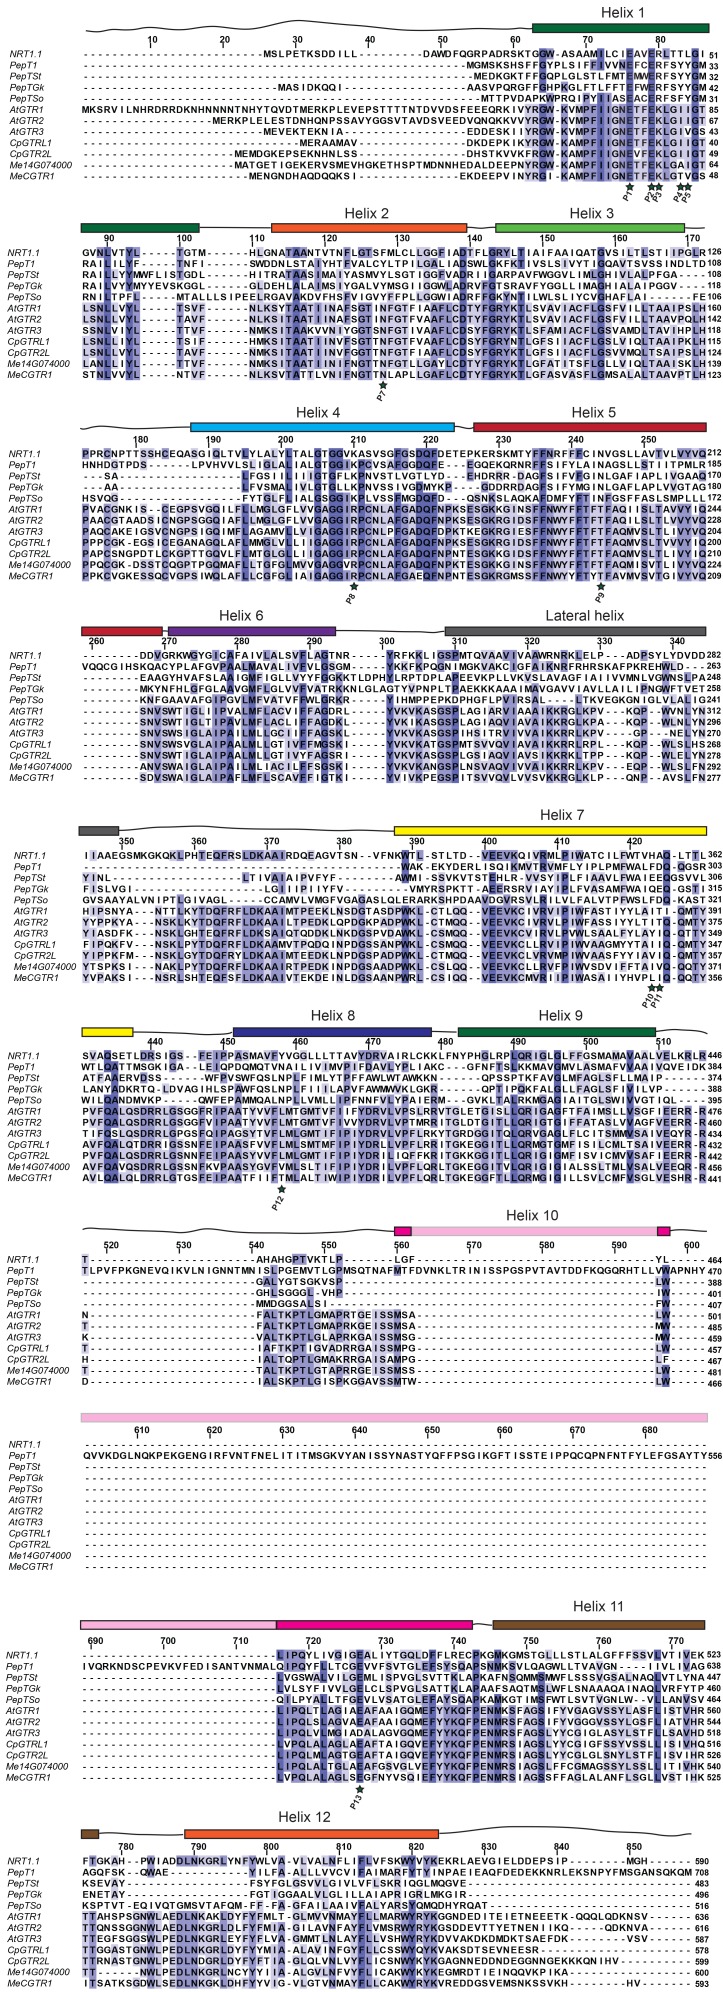
Alignment of glucosinolate and cyanogenic glucoside transporters with NPF6.3 and selected POT transporters.Amino acid alignment of AtGTR1, AtGTR2, AtGTR3, CpGTRL1, CpGTRL2, Me14g74000 and MeCGTR1 with NPF6.3, PepTSo, PepTSt, PepT1 (human) and PepTGk using MUSCLE (Edgar, 2004) and visualized with JalView (Waterhouse et al., 2009). Residues involved in nitrate and peptide binding are highlighted by a star and numbered P1-P15 (Doki et al., 2013; Solcan et al., 2012; Parker and Newstead, 2014; Sun et al., 2014; Newstead et al., 2011; Lyons et al., 2014). Helixes are indicated above the alignment and based on NPF6.3 annotation.